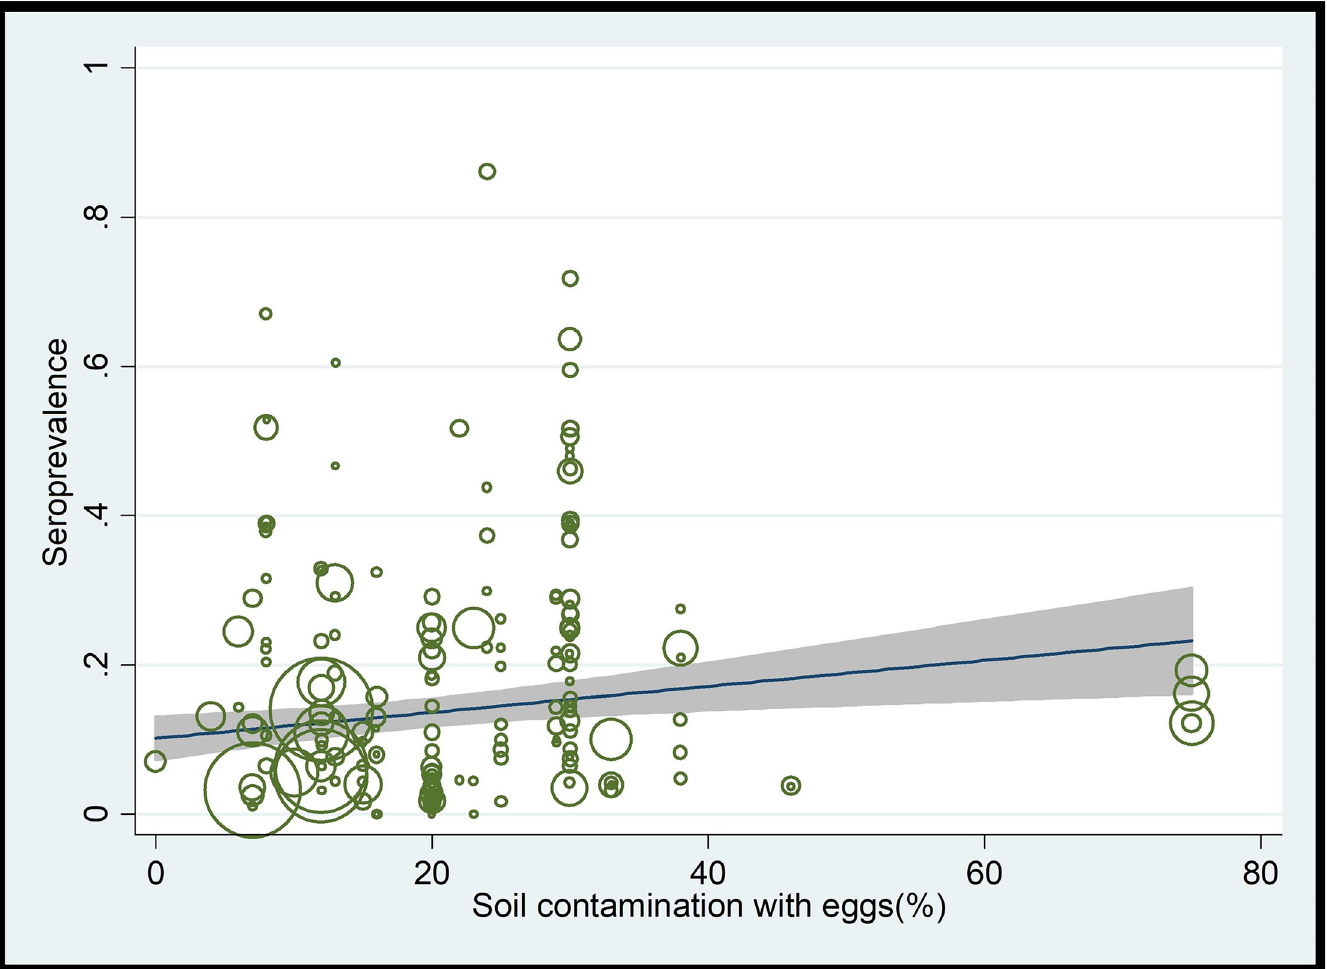
Fig 4. Meta-regression analysis showing a non-statistically significant upward trend in the rates of T -seroprevalence in humans with increasing contamination of soil with Toxocara eggs. https://doi.org/10.1371/journal.pntd.0007809.g004 PLOS NeglectedTropical Diseases | https://doi.org/10.1371/journal.pntd.0007809 December19,